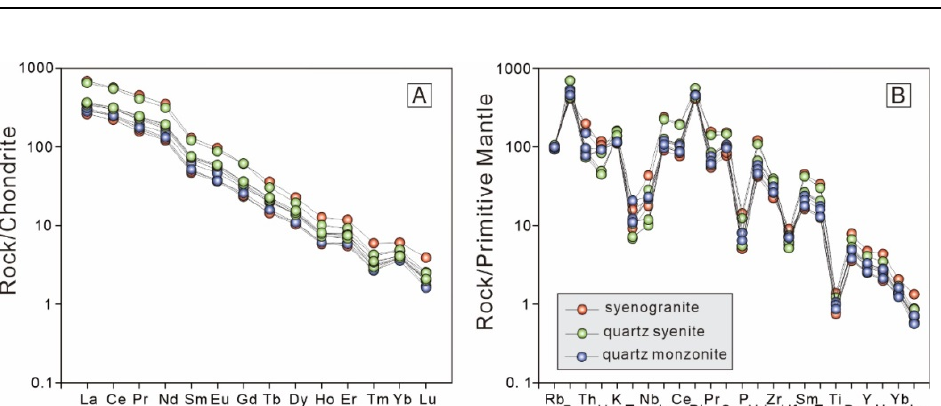
Figure 4. Geochemical classification plots of the syenogranite, quartz syenite and quartz monzo ‐ nite. ( A ) R2 (6Ca + 2Mg + Al) vs. R1 (4Si—11(Na + K)—2(Fe + Ti)) plot for classifying the rock types [32]. ( B ) (Na 2 O + K 2 O—CaO) vs. SiO 2 [33] classification diagram for evaluating the calcic to alkalic variations. ( C ) (Na + K)/Al vs. SiO 2 plot [34]. ( D ) A/NK [molar Al 2 O 3 /(Na 2 O + K 2 O)] vs. A/CNK [molar Al 2 O 3 /(CaO + Na 2 O + K 2 O)] for evaluating peralkaline, metaluminous and peraluminous melt compositions [35].